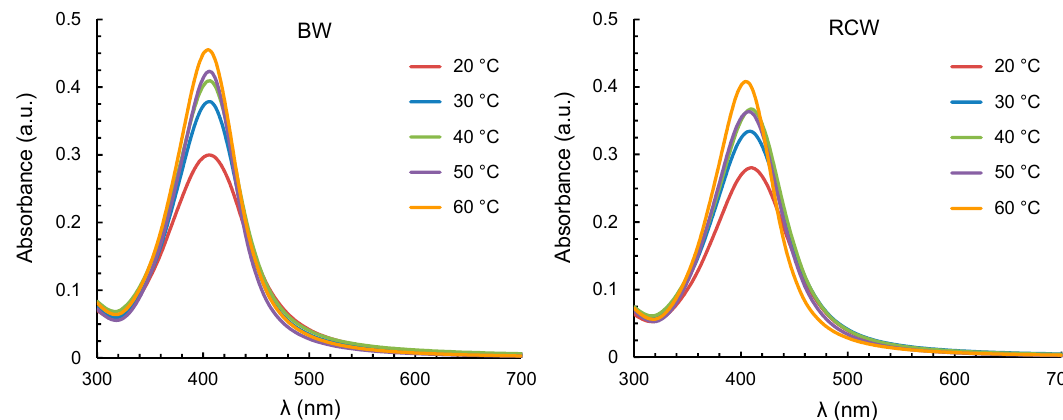
Figure 4. Effect of temperature on the SPR band of Ag-NPs obtained from bilberry waste (BW) and red currant waste (RCW) (other conditions: pH = 11; Reaction time = 5 h; Silver-to-polyphenol ratio = 10 mol Ag + /mol GAE).